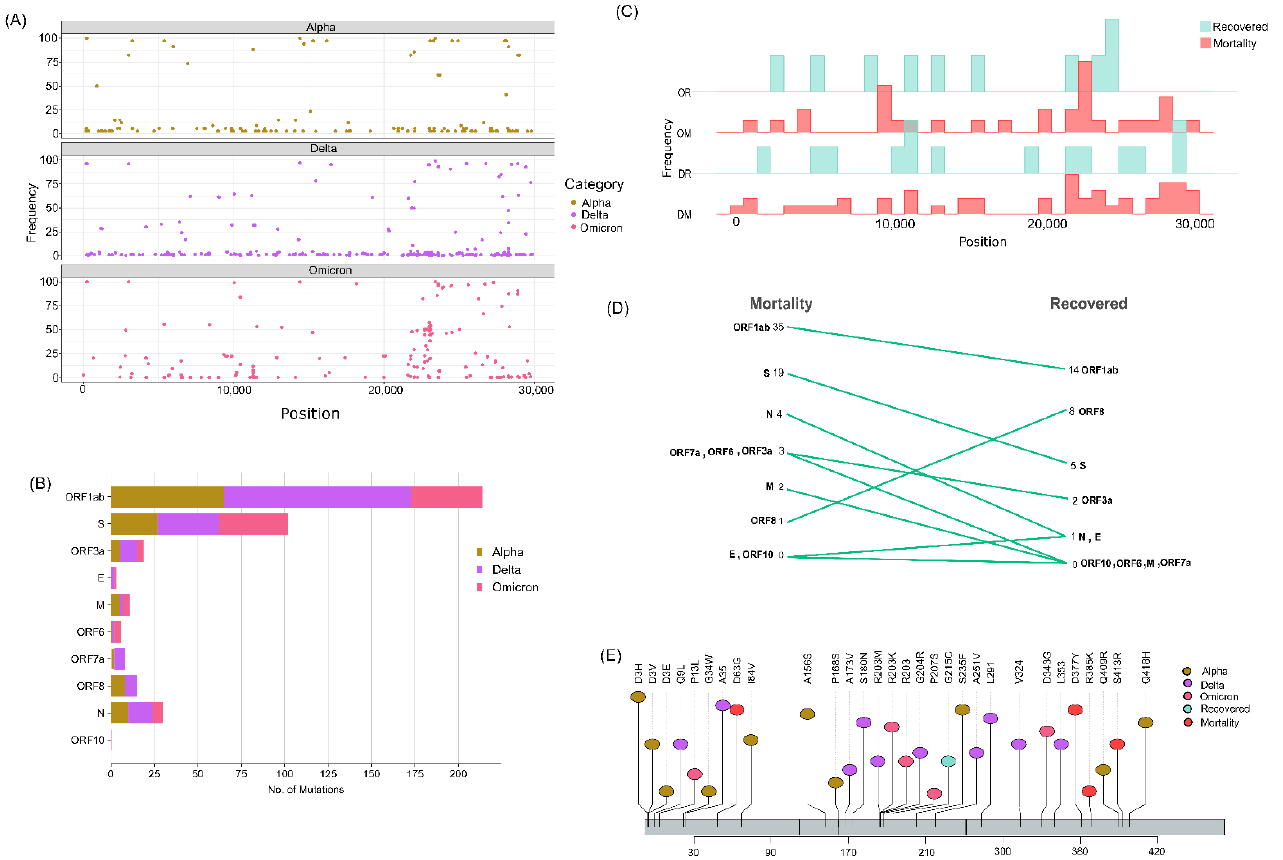
Figure 4. Significant mutations across the study cohorts in the whole genome and different sub- genomic regions. ( A ) Significant mutations associated with Alpha, Delta, and Omicron. ( B ) Mutation count across the sub-genomic regions of SARS-CoV-2. ( C ) Significant mutations associated with the clinical outcome groups of DR, DM, OR, and OM. ( D ) Mutation count in the clinical outcome groups correlated with the distinct genomic regions of SARS-CoV-2. ( E ) Lollipop plot displaying significant mutations of N gene across the study cohorts.